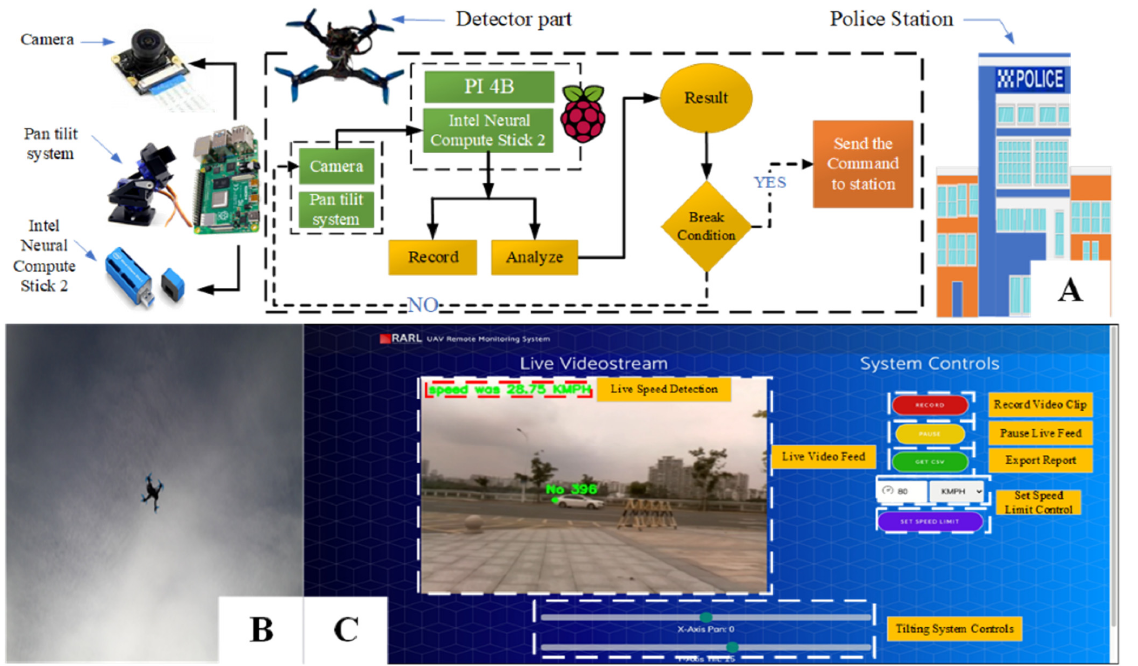
Figure 1. Proposed speed detection system ( A ) the total system scheme and logic, ( B ) the proposed UAV, ( C ) the system performance and designed GUI.